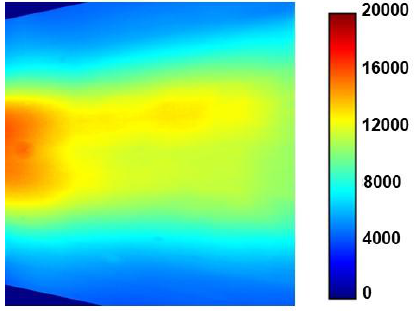
Fig. 3. Light-sheet brightness distribution.